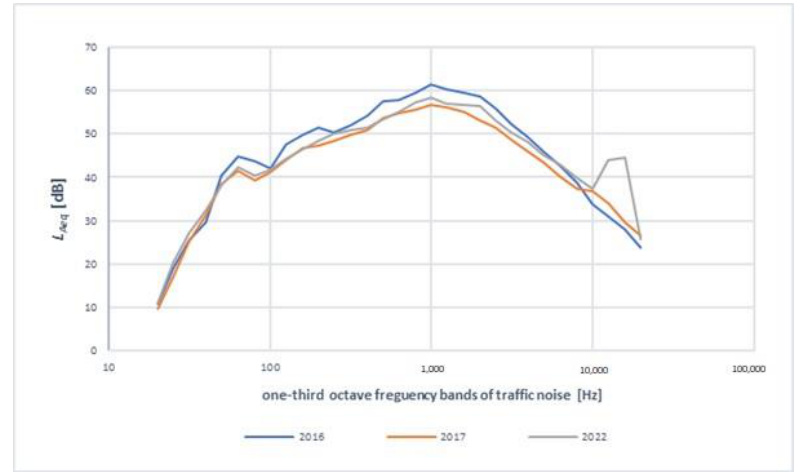
Figure 7. Comparison in 1 – 3 octave bands for equivalent noise levels from road traffic before and after the reconstruction of an intersection in Zilina at MS1 for years 2016 (before reconstruction), 2017 (immediately after reconstruction), and 2022 (five years after reconstruction).